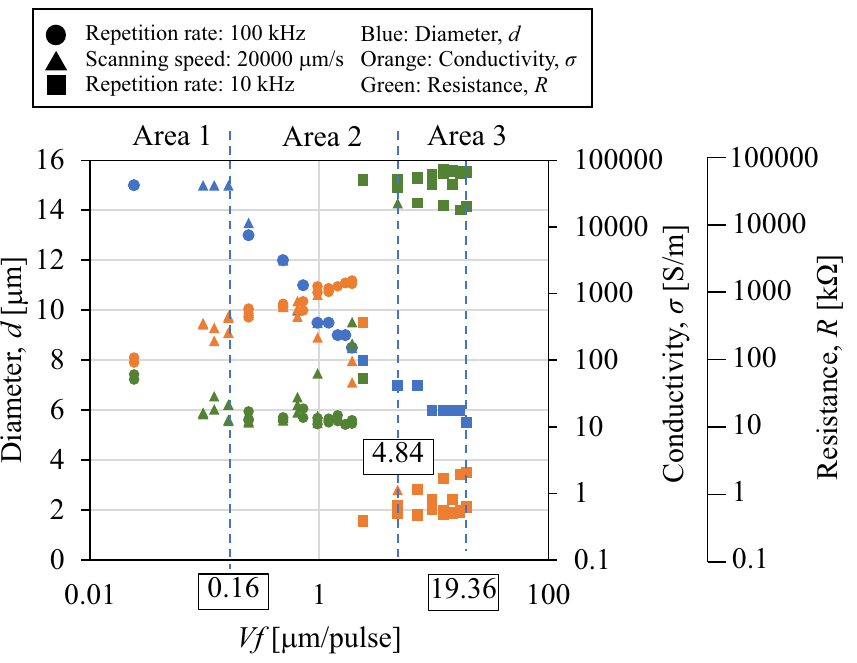
Figure 5. Relationship between Vf and the diameter/conductivity/resistance of wire-shaped modified